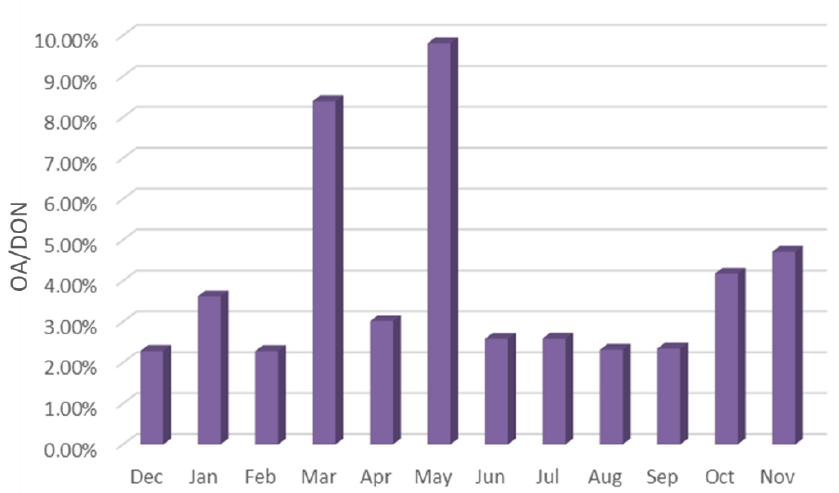
Figure 16. Proportion of OA in DON (December 2020–November 2021).